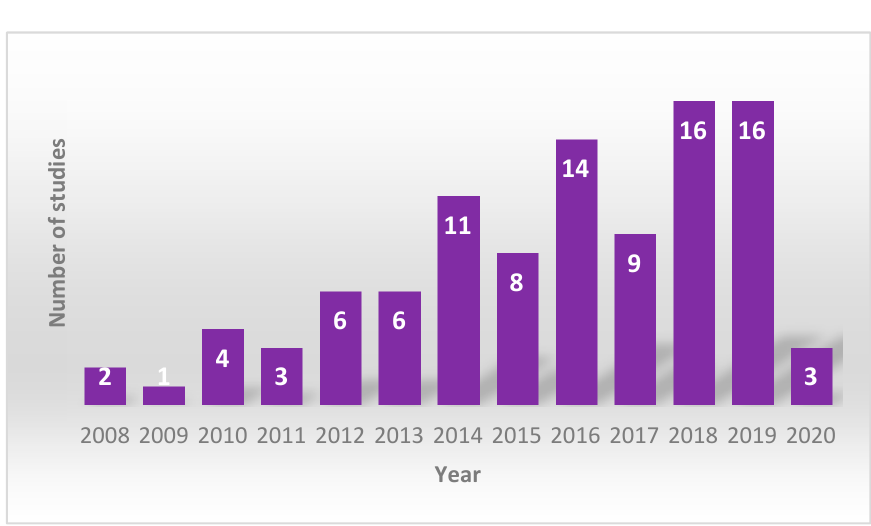
Figure 4. Publications per year.